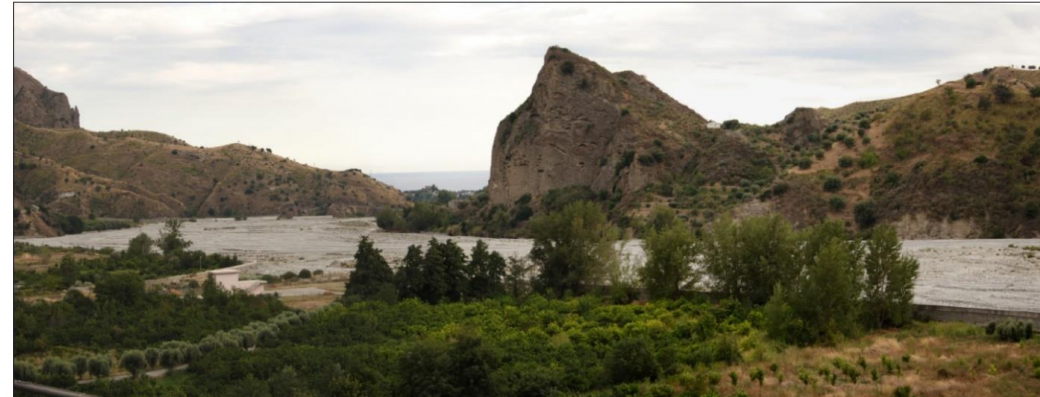
Figure 7. The assumption that dynamic equilibrium is ‘the target’, as implicitly a priori by [18,51], can lead to no escape situations: for instance, what level of health should we assign to the Fiumara Amendolea, a naturally aggrading river? From an anthropogenic point of view, undoubtedly, that river poses serious threats (see [54]), yet from a nature conservation point of view, we cannot state it is in bad health, because that is its intrinsic nature, at least in a contemporary time scale. (Photo: Andrea